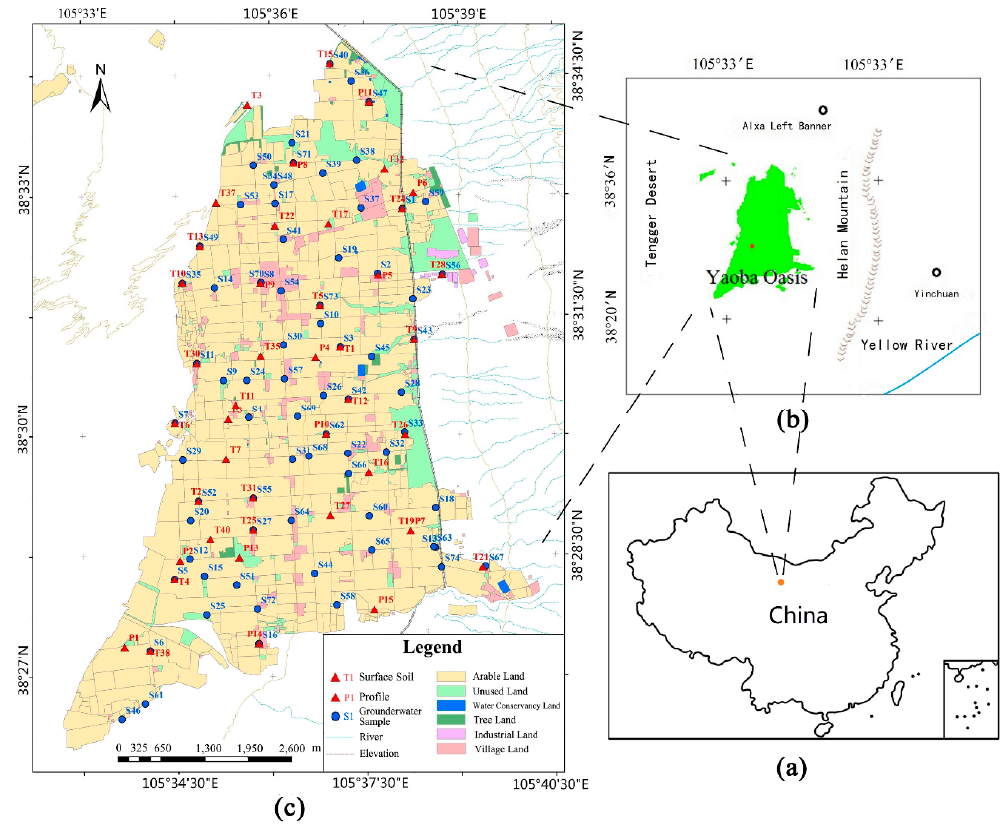
Figure 1. Location map of the study area: ( a ) map showing the location of the study area in China; ( b ) map showing the location of Yaoba Oasis; and ( c ) map showing the land use and distribution in the study area.